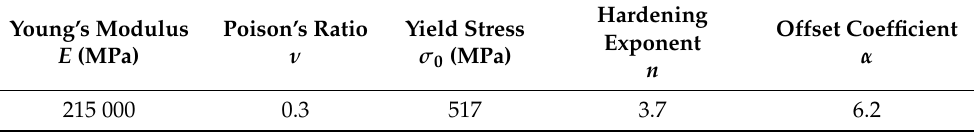
Figure 1. Geometry sizes: ( a ) SE(B); ( b ) C(T) specimens. Table 2. Constitutive parameters of 22NiMoCr3-7 steel at − 60 ◦ C [13].